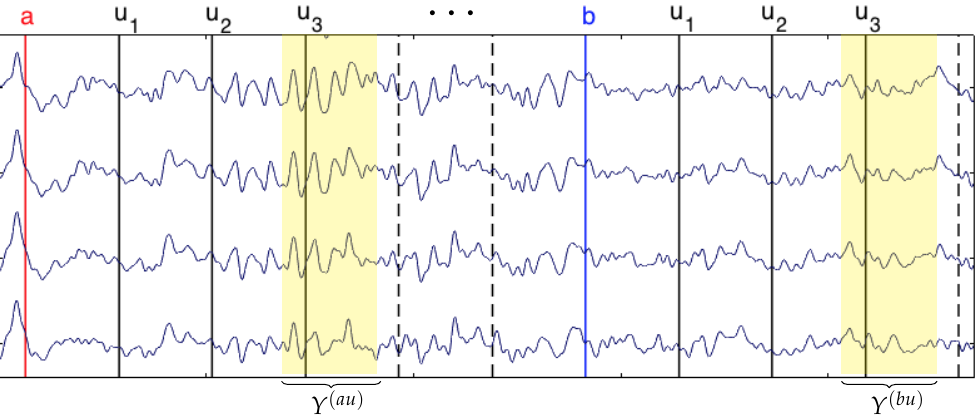
Figure 2. EEG signals recorded from four electrodes. The sequence of stimuli is indicated in the top horizontal line. Vertical lines indicate the beginning of the successive auditory units. The distance between two successive vertical lines is T > 0. Solid vertical lines indicate the successive occurrence ( a u ) times of the string u . The first yellow strip corresponds to the chunk Y n associated to the string a u . ( b u ) The second yellow strip corresponds to the chunk Y n associated to the string b u